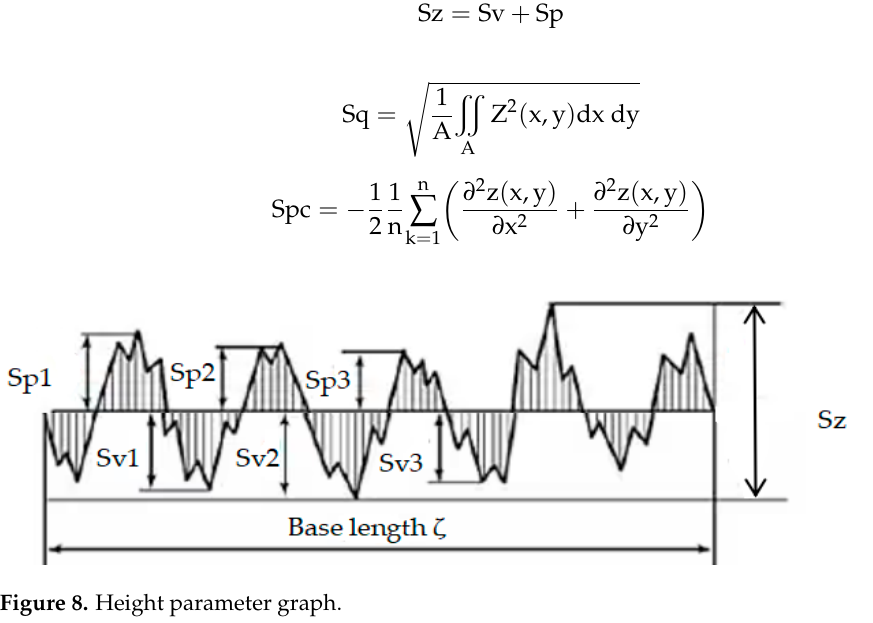
Figure 8. Height parameter graph.